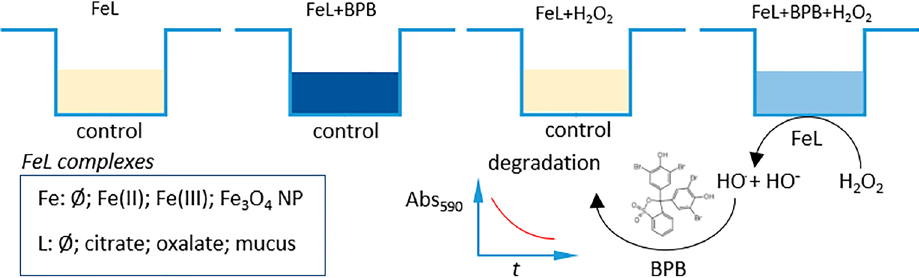
Figure 5. Experimental protocol for the quantitative determination of hydroxyl radical production from Fenton reaction with several iron/ligand systems at pH 7.0. The experiment is performed on 96-wells microplate with final reaction volumes of 200 µL/well. For each FeL system under study the combination of control and “full reaction” situations enables to determine the kinetic evolution of BPB degradation induced by radical hydroxyl